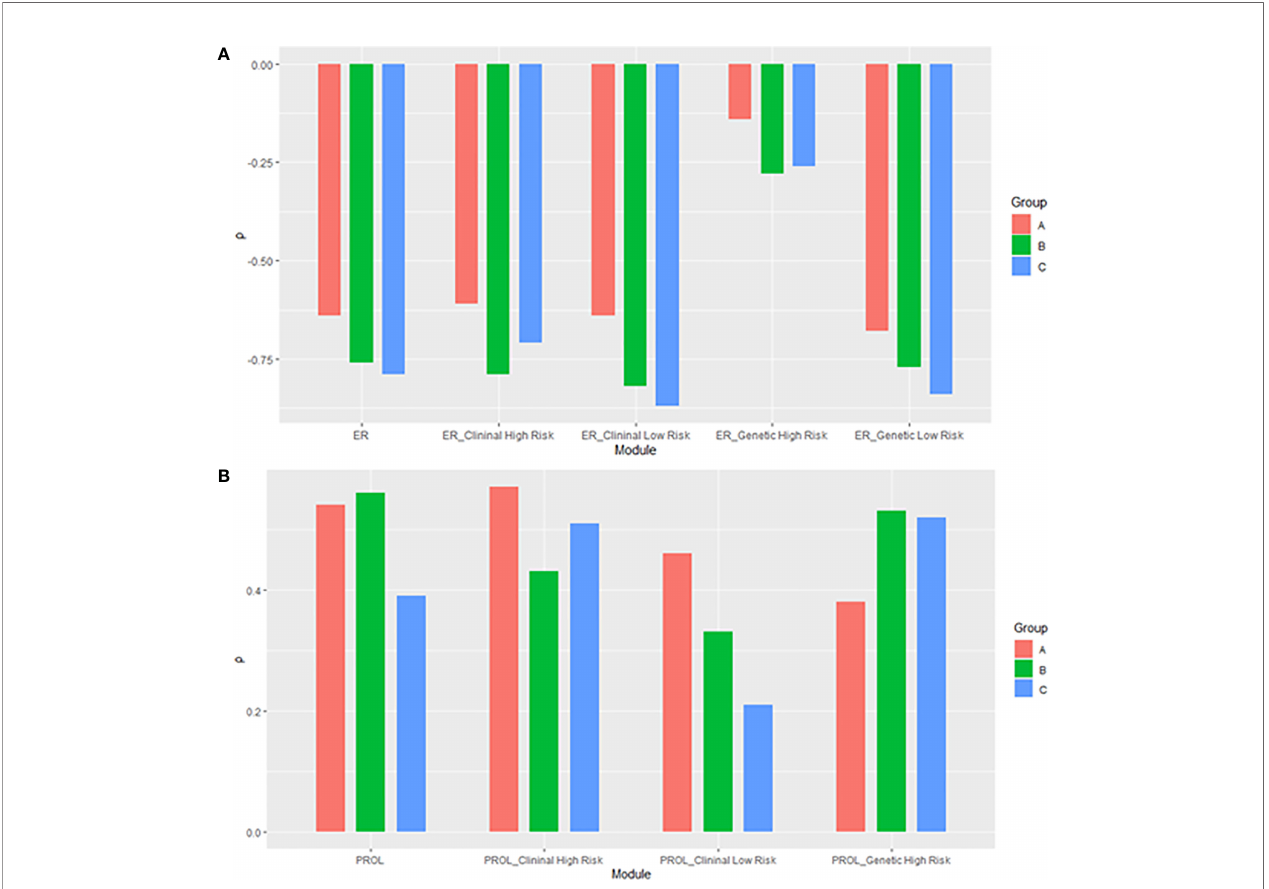
FIGURE 9 | The histogram of relationships of the RS with its (A) estrogen and (B) proliferation module. The subgroup of proliferation module with genetic low risk was omitted due to non-signi fi cance. ER, estrogen receptor; PROL,